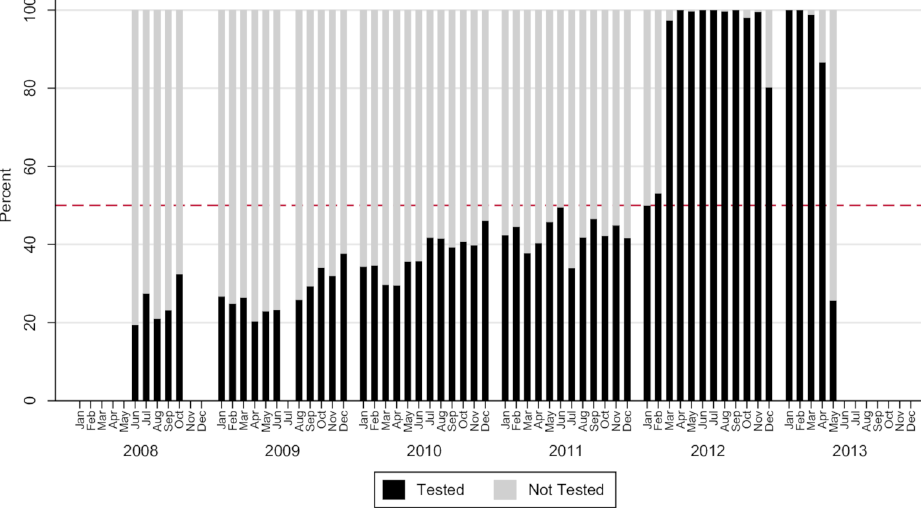
Fig 2. Proportion of women in labour reporting antenatal counselling and testing for HIV, June 2008 to May 2013 (n = 22,458). Legend. The figure displays the percentage of women who reported testing for HIV during antenatal visits by calendar month and year. A notable increase is seen between 2011 and 2012, after which testing declines in May